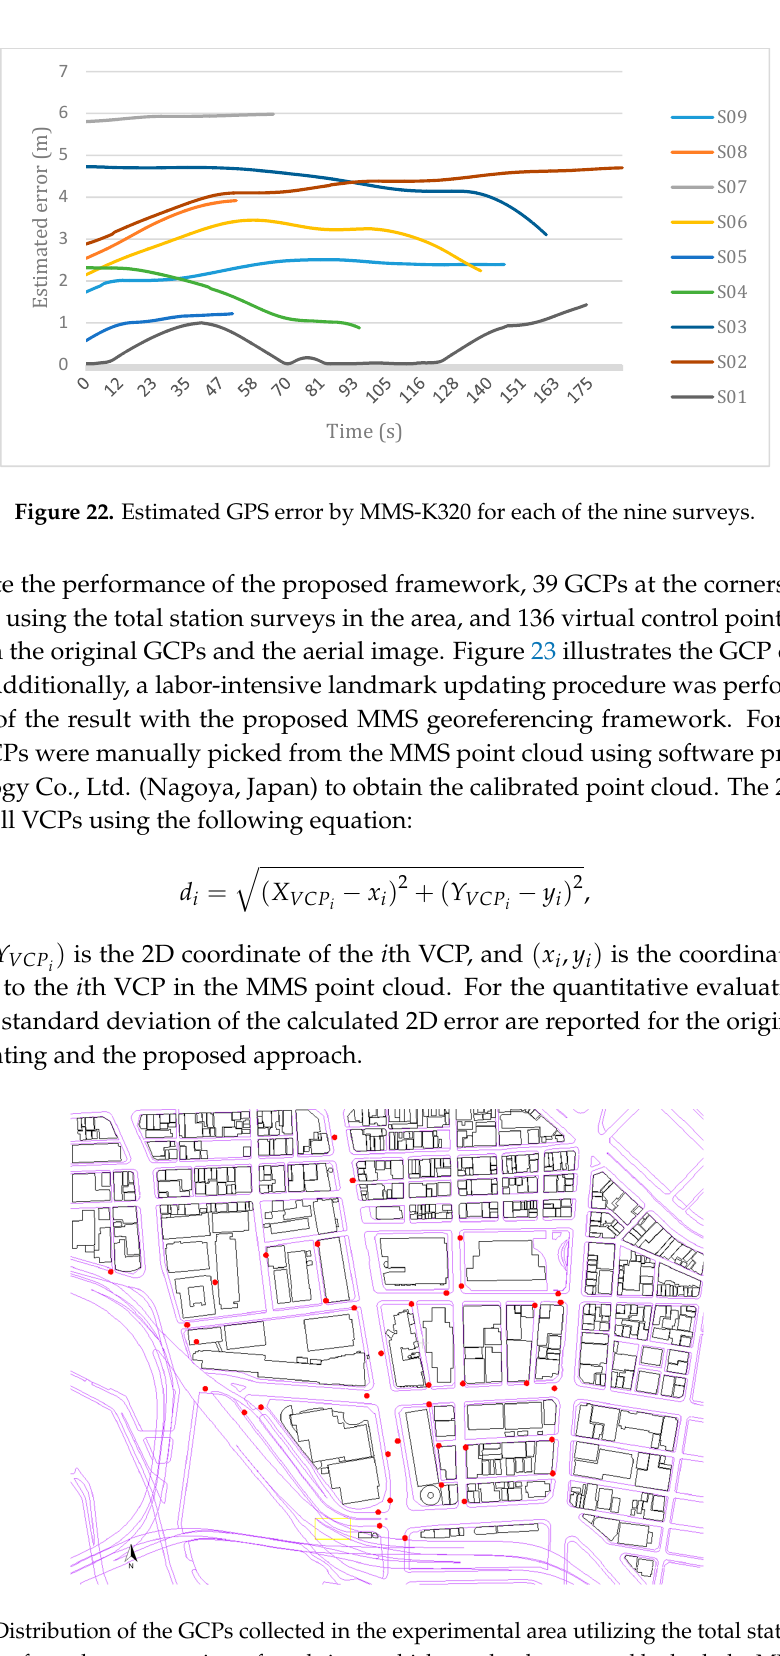
Figure 23. Distribution of the GCPs collected in the experimental area utilizing the total station survey. The GCPs are from the corner points of road signs, which are clearly captured by both the MMS camera and the point cloud.